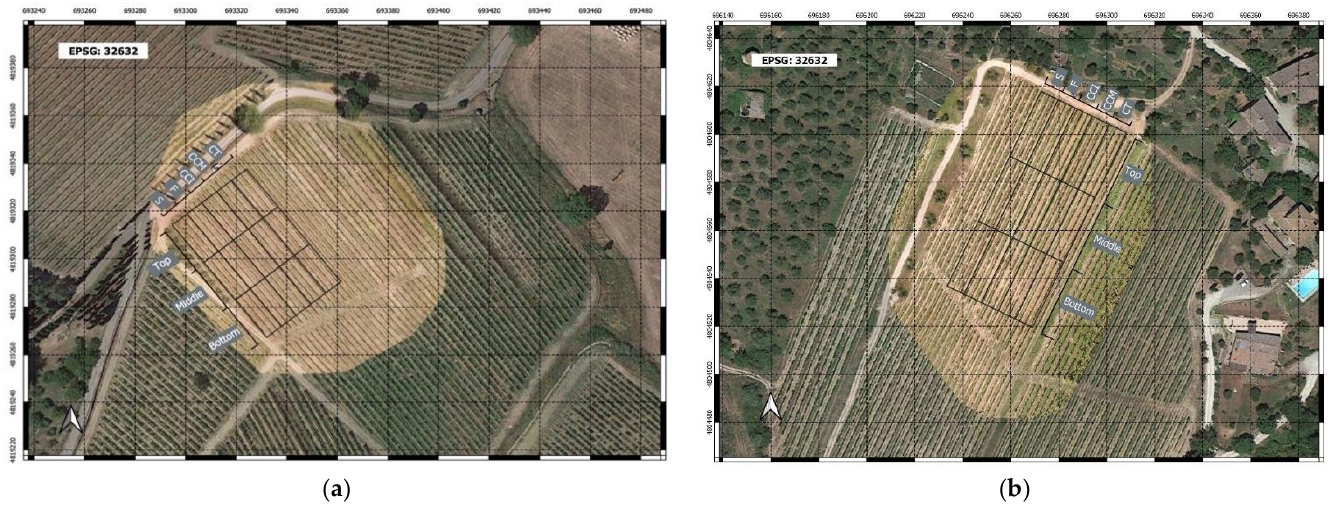
Figure 1. Experimental fields and their set-up for Montevertine ( a ) and San Giusto a Rentennano farm ( b ). An in-row ventral plough was used to control weeds under the trellis during the season in all the treatments. The cover crops were sown in October and terminated in mid-June for both experimental